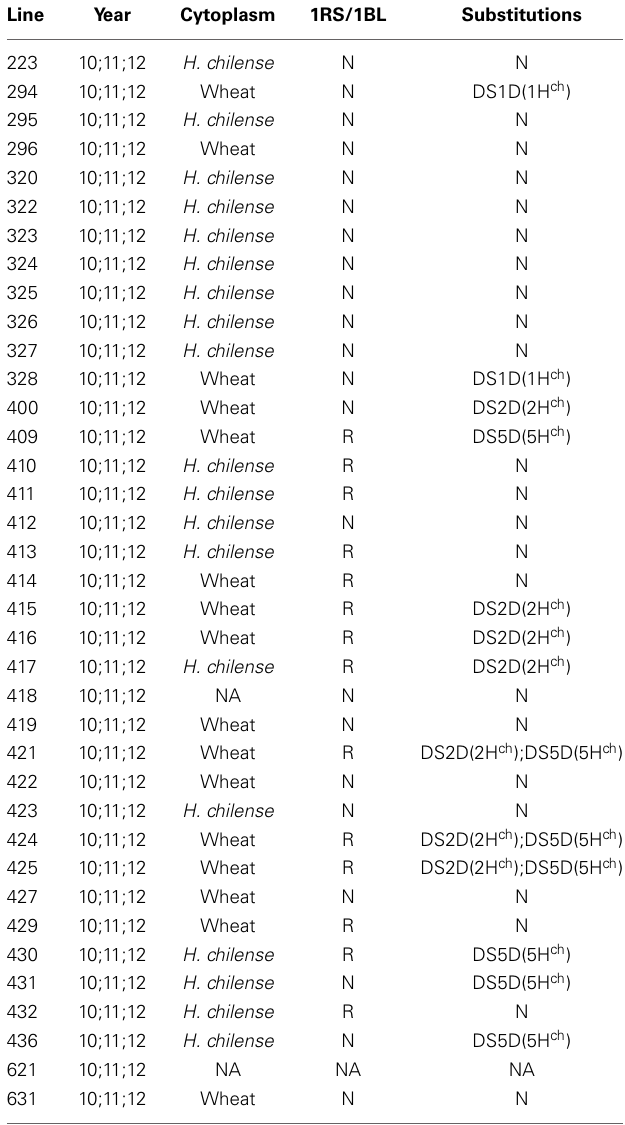
Table 1 | Tritordeum collection used in this